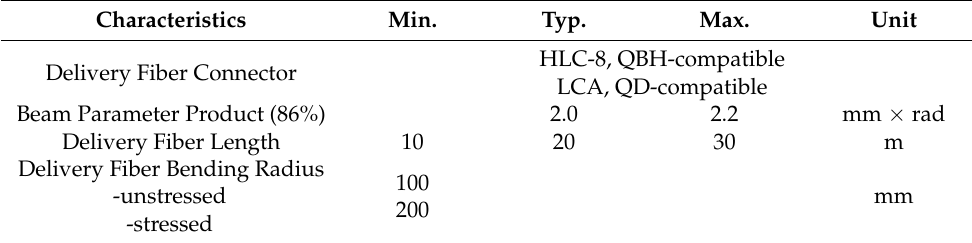
Table 2. Optical output of laser resonator.